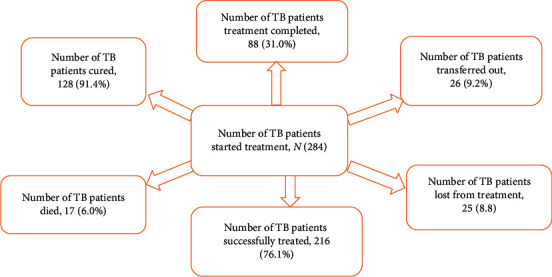
Treatment outcome of tuberculosis patients in Addis Ababa, 2019.